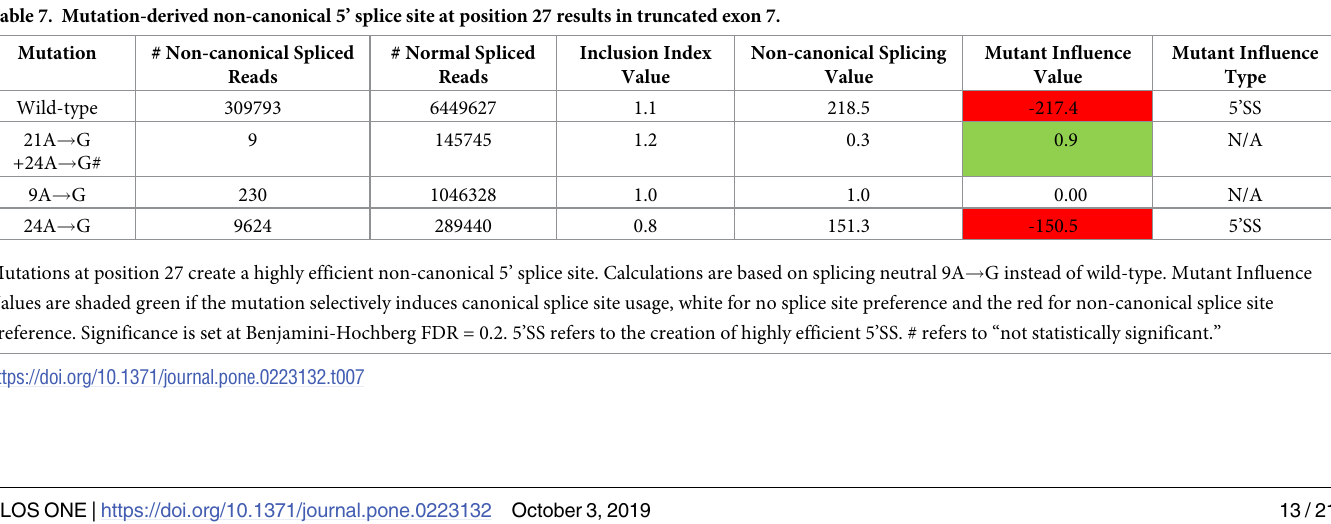
Table 7. Mutation-derived non-canonical 5’ splice site at position 27 results in truncated exon 7. Mutation